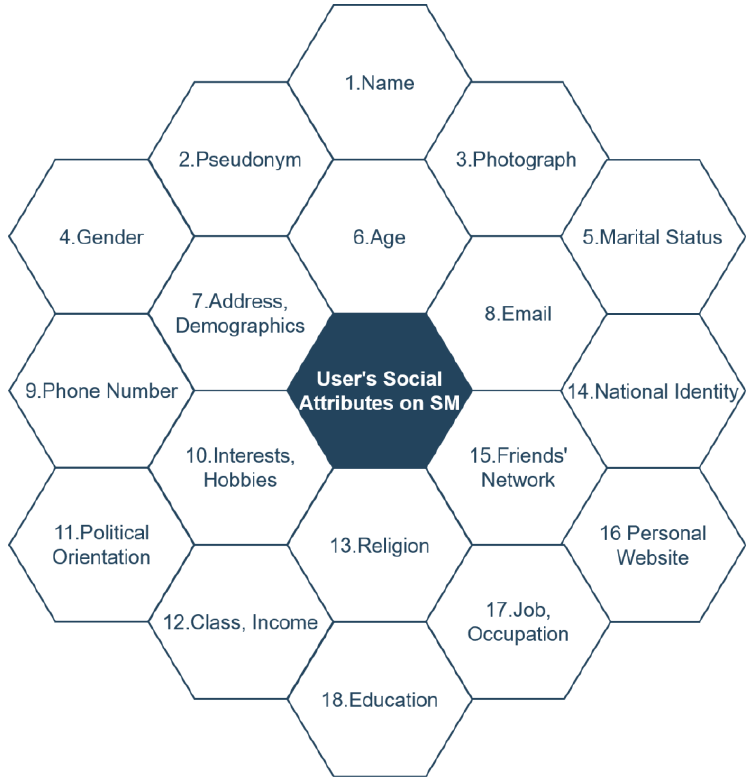
Figure 3. User’ s Social Attributes on Social Media.